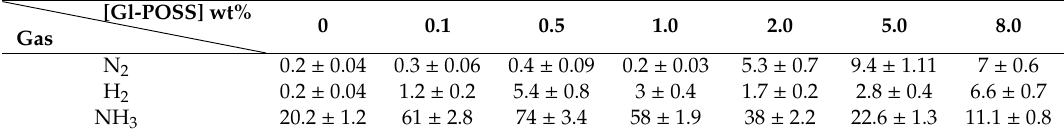
Table 5. The sorption coe ffi cients ( S × 10 4 , mol m − 3 Pa − 1 ) of single gases.